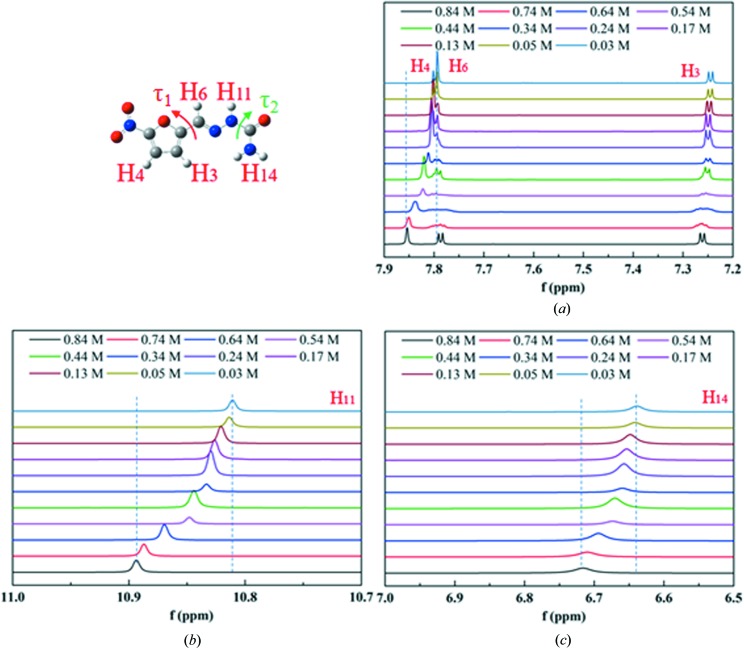
(a) 1HNMR spectra of H3, H4 and H6 at different concentrations. (b) 1HNMR spectra of H11 at different concentrations. (c) 1HNMR spectra of H14 at different concentrations.